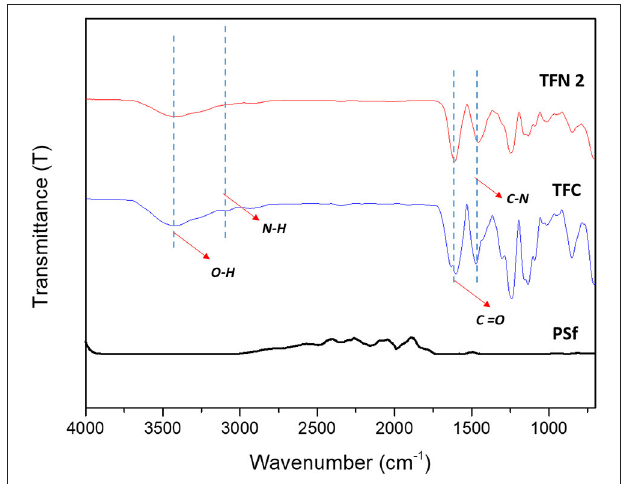
FIGURE 2 | Chemical functional group by FTIR of PSf, TFC, and TFN membranes.